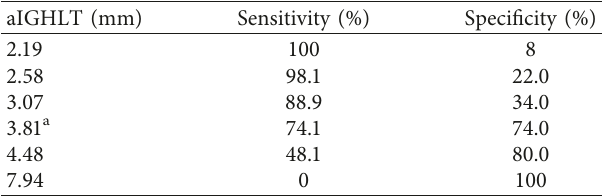
a The best cut-off point on the receiver operating characteristic (ROC) curve. Abbreviations: aIGHLT, anterior band of inferior glenohumeral ligament thickness.